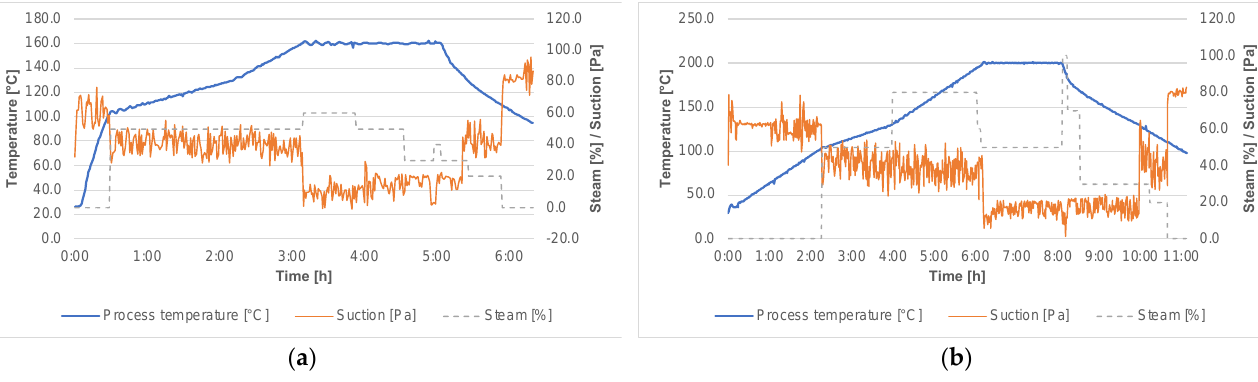
Figure 2. Technological parameters of the modification process of heat-treated wood at 160 °C ( a ), and at 200 °C ( b ).